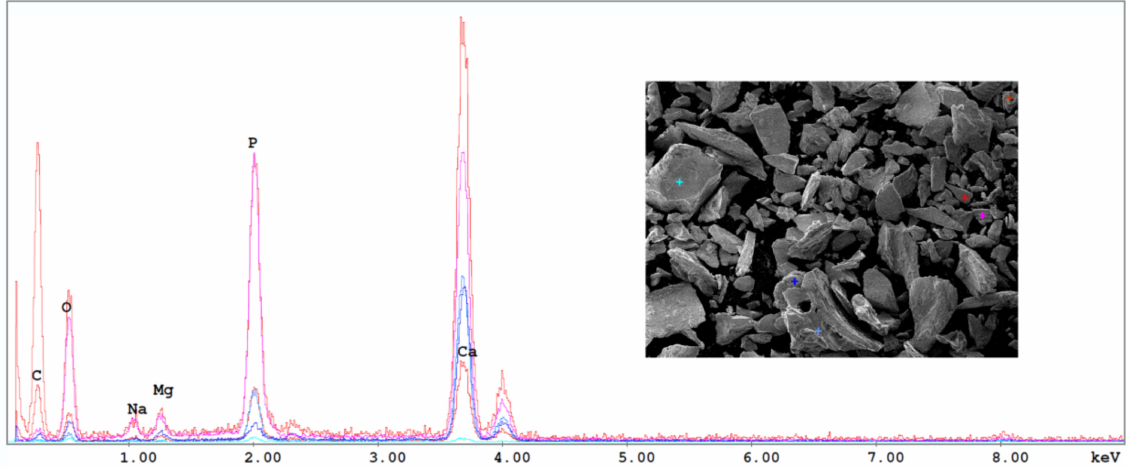
Figure 4. Energy dispersive spectroscopy spectrum obtained at several points of the sample Scorpaena scrofa at 950 ◦ C.